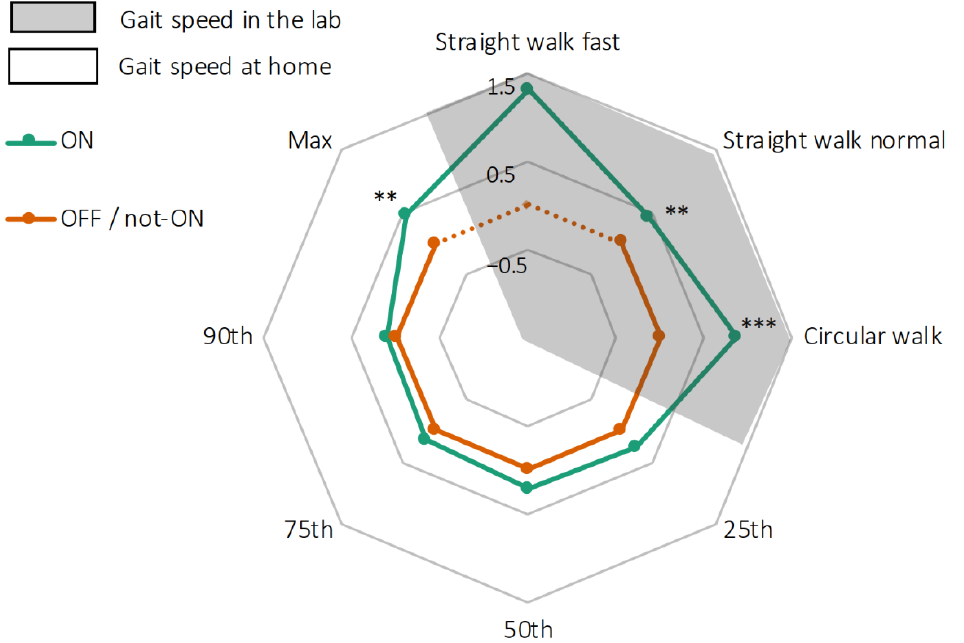
Figure 3 . Radar plot illustrating gait speeds of 27 PD patients during lab tests (in grey) and in their domestic environment (white, presented by different percentiles). Gait speeds during medication OFF in the lab and not-ON in the domestic environment are presented as 0 (orange line), and gait speeds during medication ON are presented as deviation from 0 (green line). Straight walking test at fast pace was not performed during OFF medication state (dotted orange line). ** p < 0.01, *** p < 0.001.